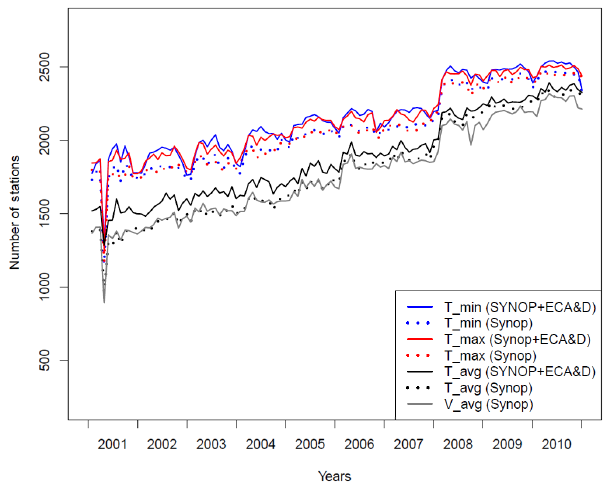
Figure 4. Temporal evolution of total input data used for the inter- polations 2001–2010 (see color code). The dotted curves show the basic number made up by SYNOP stations. The differences indi- cate the increase by the inclusion of ECA&D data. SYNOP data are used for the interpolations for wind speed